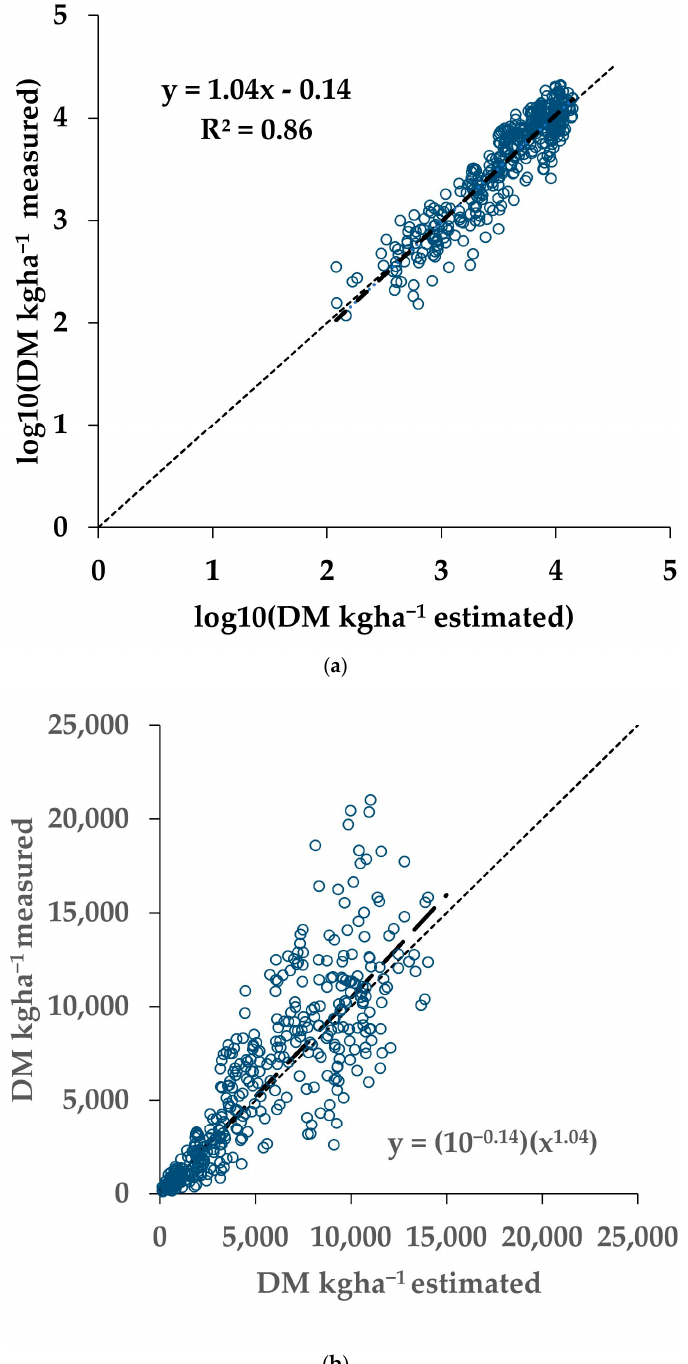
Figure 4. Validation data representing 20% (N = 416) of the Training dataset. Both the biomass and sNDVI data were transformed using log10 prior to fitting. ( a ) Measured versus estimated AGB in log10 transformation. ( b ) Measured versus estimated AGB transformed back from